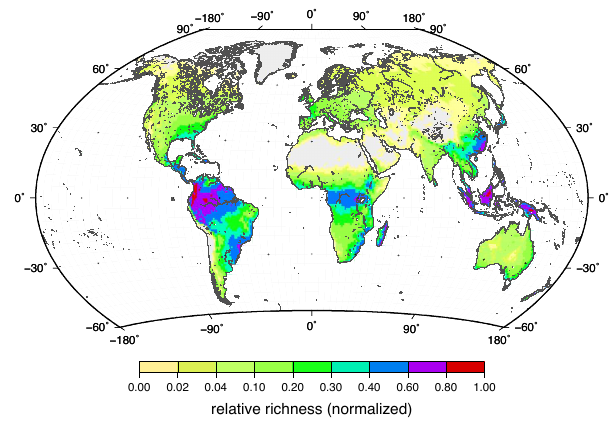
Fig. 1. Simulated functional richness (FR) defined as the number of different PGS at each grid cell. Values are expressed in relative numbers (i.e. normalized to the maximum FR). figure